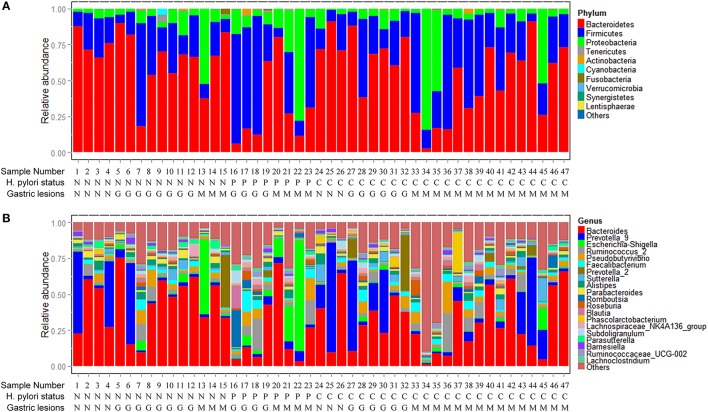
Composition of fecal microbiota. (A) Relative abundance distribution of major phyla (top 10) in 47 fecal samples. Phyla were sorted by decreasing order of average relative abundance. H. pylori status and gastric lesions observed for each subject are listed below. (B) Relative abundance distribution of major genera (top 20) in 47 fecal samples. Genera were sorted by decreasing order of average relative abundance as in (A). H. pylori status: N, H. pylori negative; P, past H. pylori infection; C, current H. pylori infection. Gastric lesions: N, normal; G, gastritis; M, metaplasia.